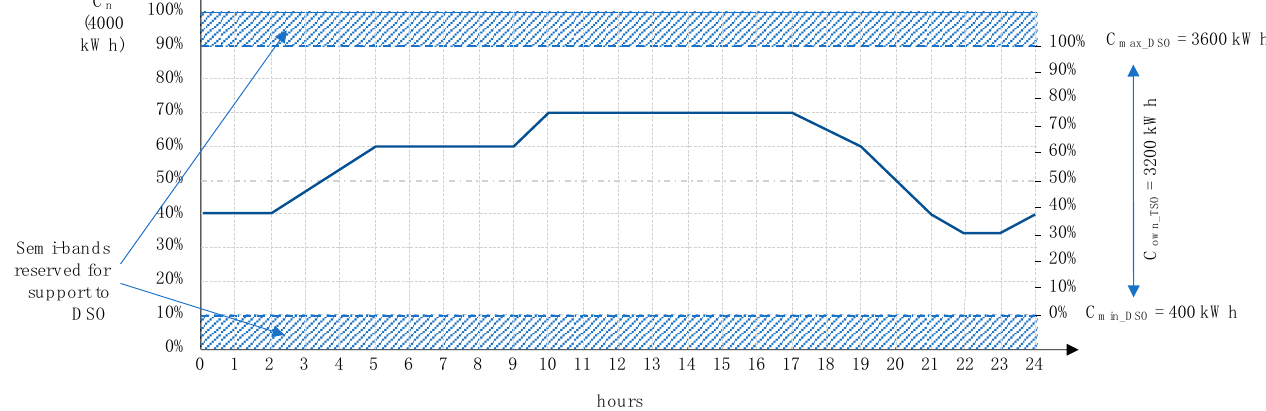
Figure 2. Decoding of the chromosome of Figure 1: BESS with P n = 1 MW and d n = 4 h; C DSO = 800 kWh (20% of C n ) reserved for DSO; upper and lower semi-bands of 400 kWh; depending on the SoC, the virtual storage can be used as a BESS of 800 kW × 1 h or 400 kW × 1 h.